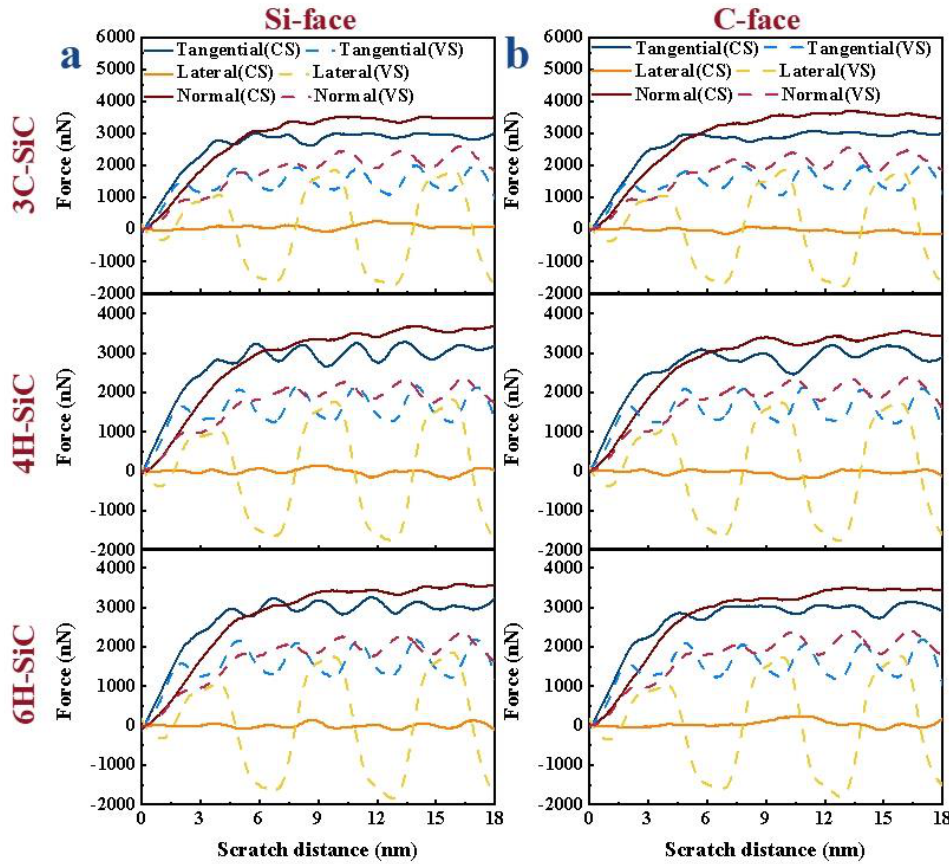
Figure 2. Comparison of conventional and vibration-assisted scratch forces of SiC polytypes: ( a ) the Si-face of 3C-, 4H-and 6H-SiC, respectively, ( b ) the C-face of 3C-, 4H-and 6H-SiC, respectively, the simulation parameters of conventional scratch are 4 nm (depth) and 100 m/s (scratch speed) and the simulation parameters of vibration-assisted scratch are 4 nm (depth), 100 m/s (scratch speed), 4 nm (amplitude) and 16.67 GHz (frequency).